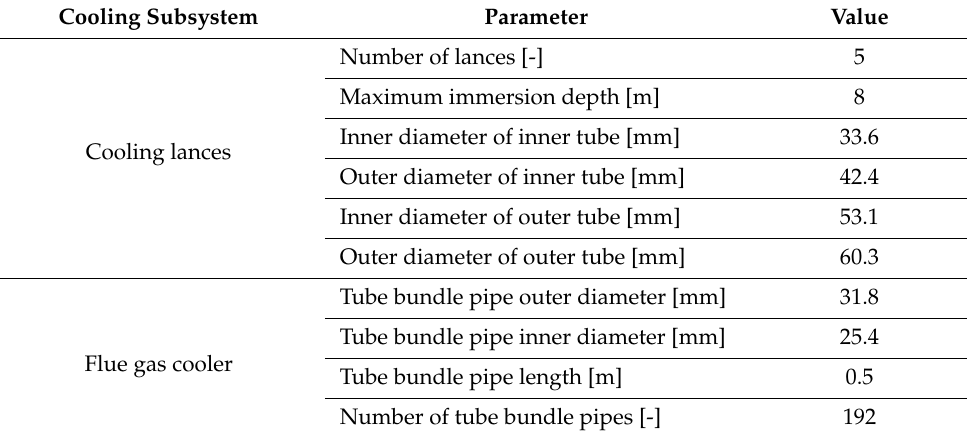
Figure 2. Simplified flow diagram of the cooling system (waterside). Table 2. Design parameters of the cooling lances and the flue gas